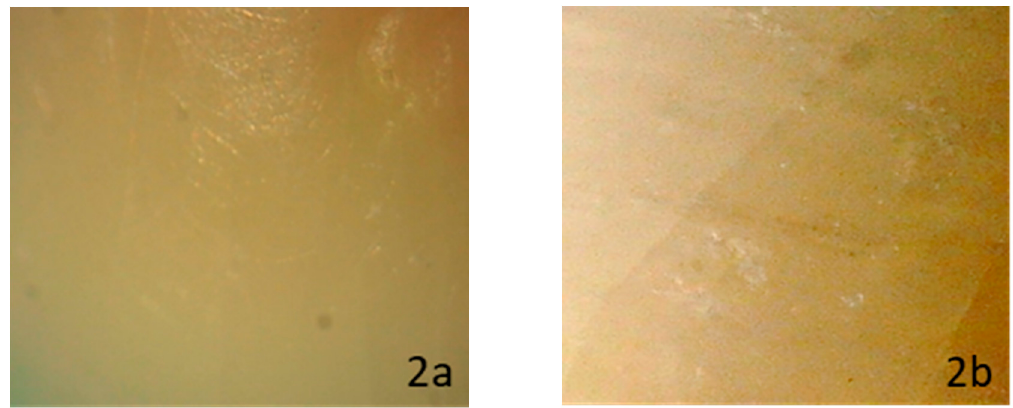
Figure 2. Stereomicroscopic evaluation showing formation of enamel microcracks after laser debonding ( 2b ) from a previously sound enamel surface ( 2a ).